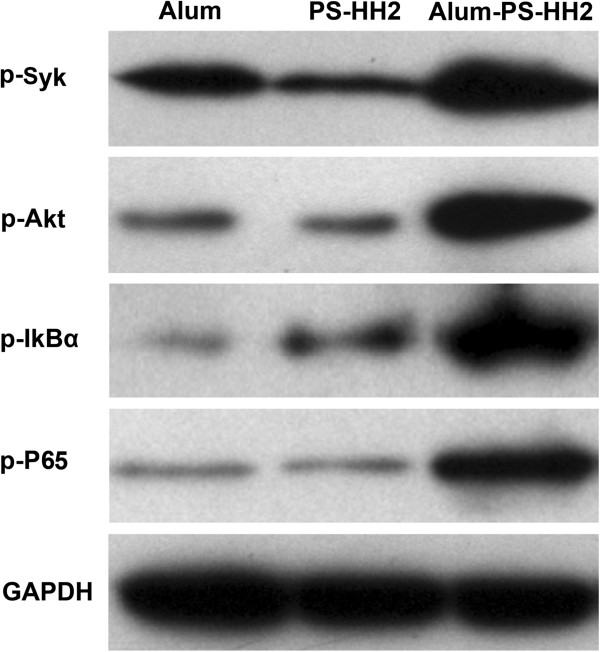
Alum and PS-HH2 synergistically triggers activation of the NF-κB signal pathway. Immature DCs derived from bone marrow were incubated and harvested on Day 5 for Western blotting. After treatment with alum (125 μg/ml), PS-HH2 (PS: 20 μg/ml and HH2: 40 μg/ml), or alum-PS-HH2 complex for 0, 5, 10 and 30 min, respectively. DCs were washed, lysed and used for Western blot analysis using antibodies to phospho-Syk, phospho-Akt, phospho-IkBα and phospho-NF-κB, respectively. GAPDH was detected on the same membrane and used as the loading control.